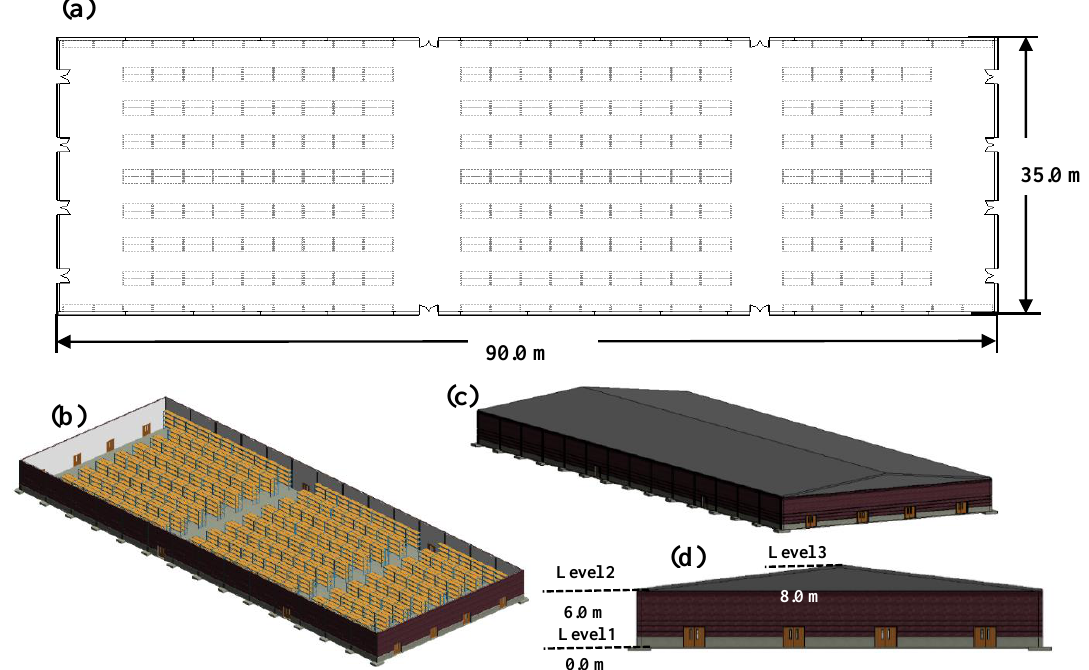
Figure A14. F15 archetype plans and sections: ( a ) Plan view; ( b , c ) 3-D views for the warehouse; ( d ) Side view for the warehouse.